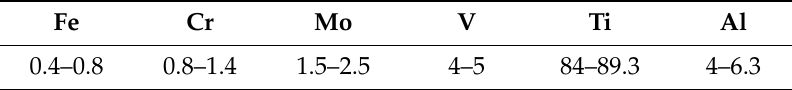
Table 2. The chemical composition of the VT23 alloy (weight %).